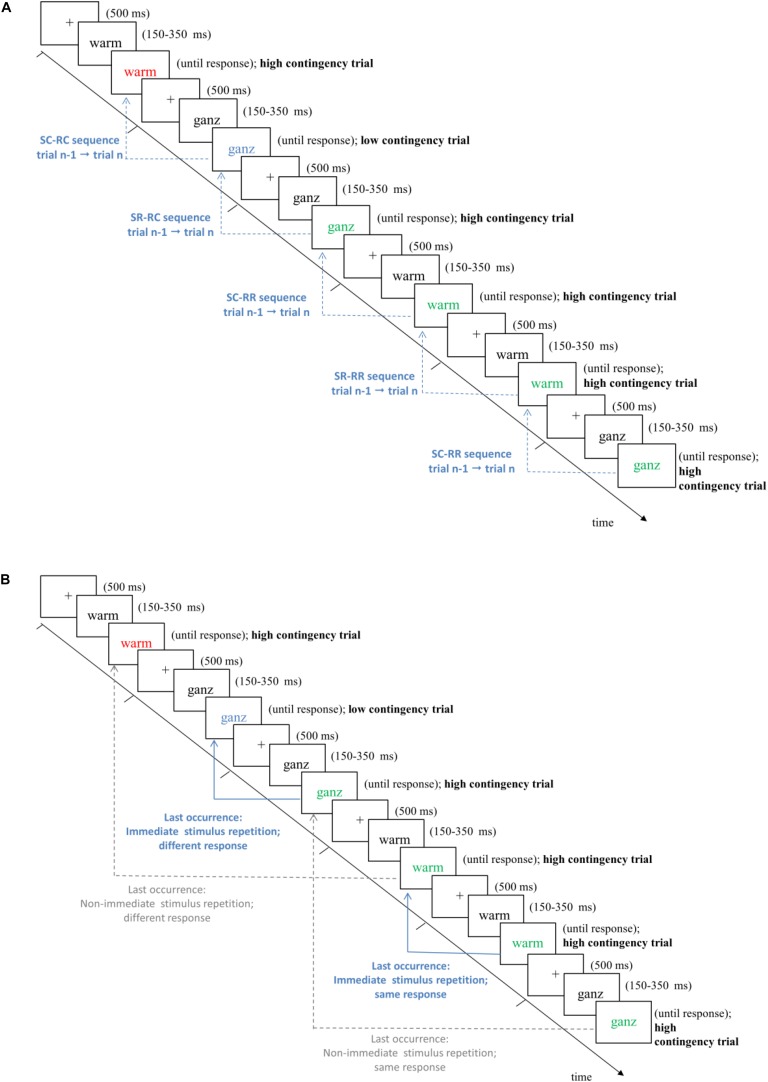
Schematic trial procedure in Experiments 1 and 2. Note that in the experiments, all stimuli were presented on black background in white font or in the respective colors (see Table 1). For both figures, we inverted the coloring scheme only for illustrative purposes. Stimuli are not drawn to scale. Trials are classified as high vs. low contingency trials (for details, see Table 1). Arrows in (A) illustrate different trial types for immediate sequence effects from trial n-1 to trial n to test for immediate SRBR effects (SR, stimulus repetition; SC, stimulus change; RR, response repetition; RC, response change). Arrows in (B) illustrate trial classification for the central analyses of interest to explain contingency learning effects by response retrieval effects, i.e., whether a given trial reflected an immediate (solid/blue lines) vs. non-immediate (dotted/gray lines) stimulus repetition trial (factor Distance) with same or different response (factor Previous Response) compared to the last occurrence of the stimulus word. See main text for details.